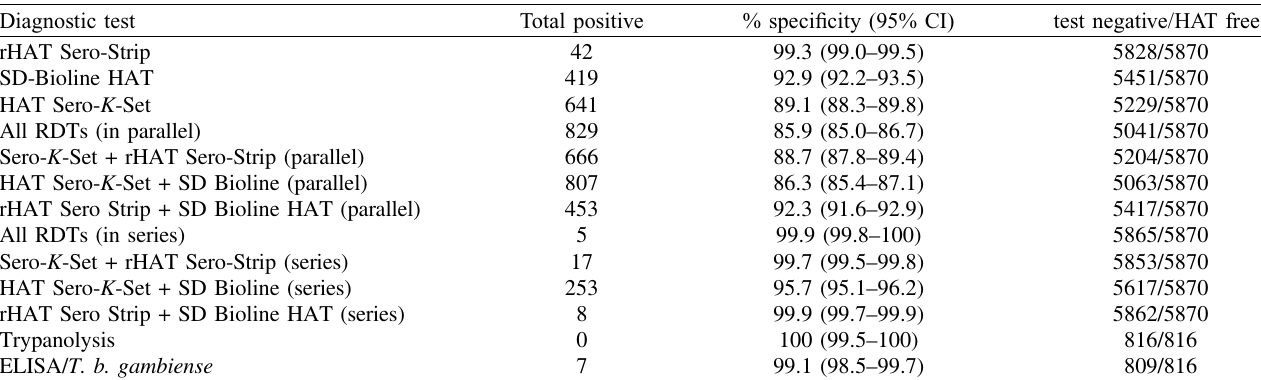
Table 2. Speci fi city of individual HAT diagnostic tests and test combinations, performed in parallel or in